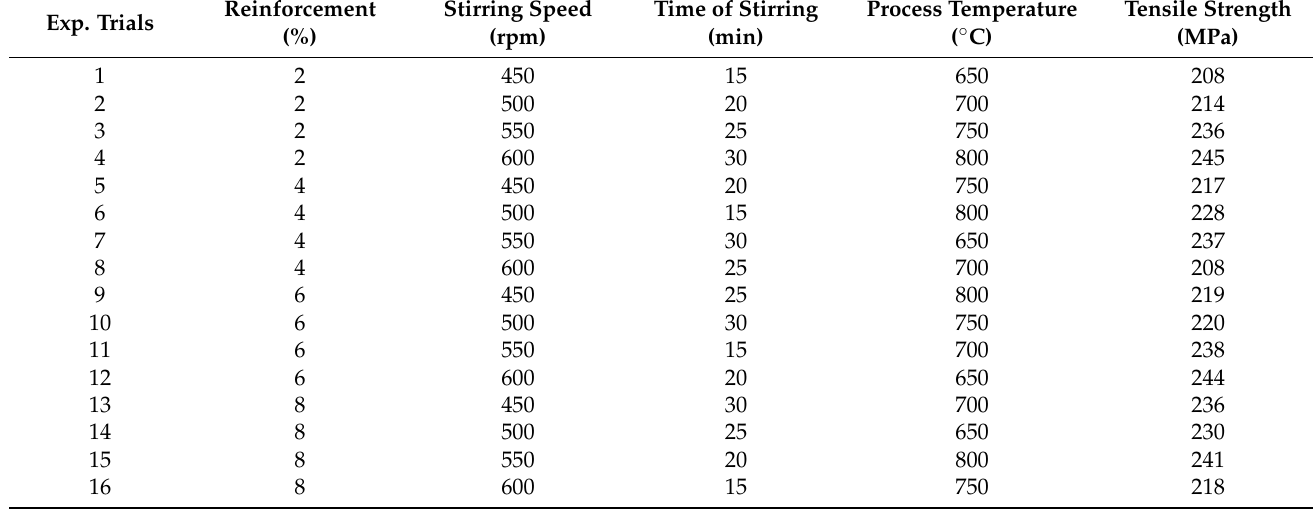
Table 9. Experimental summary of tensile strength.